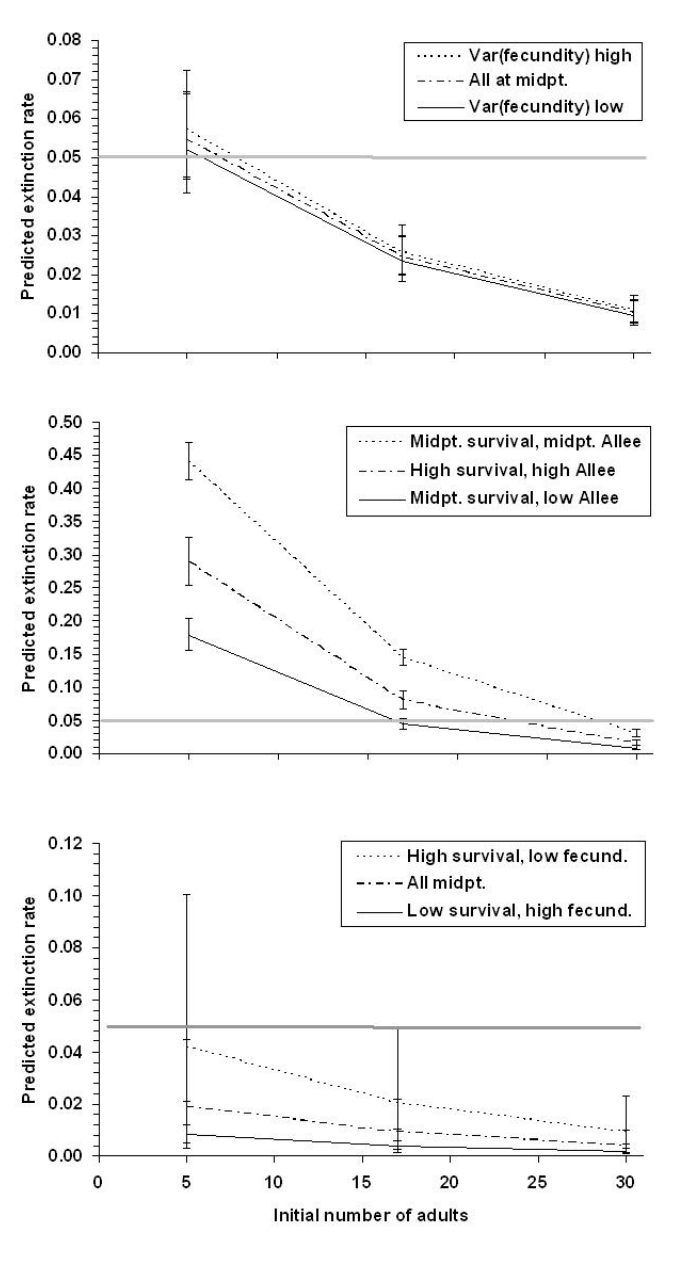
Fig. 5. Predicted rates of extinction while varying the initial number of adults in a stage-based, discrete, stochastic population viability analysis for large-bodied woodpeckers. Increasing the initial number of adults resulted in an extinction rate £ 0.05, noted with gray line, when demographic rates were intermediate while their variances decreased (A), when an Allee effect was present while demographic rates and their variances were intermediate (B), but not when demographic rates varied while their variances were intermediate (C). Whiskers represent 95% confidence limits ( n =